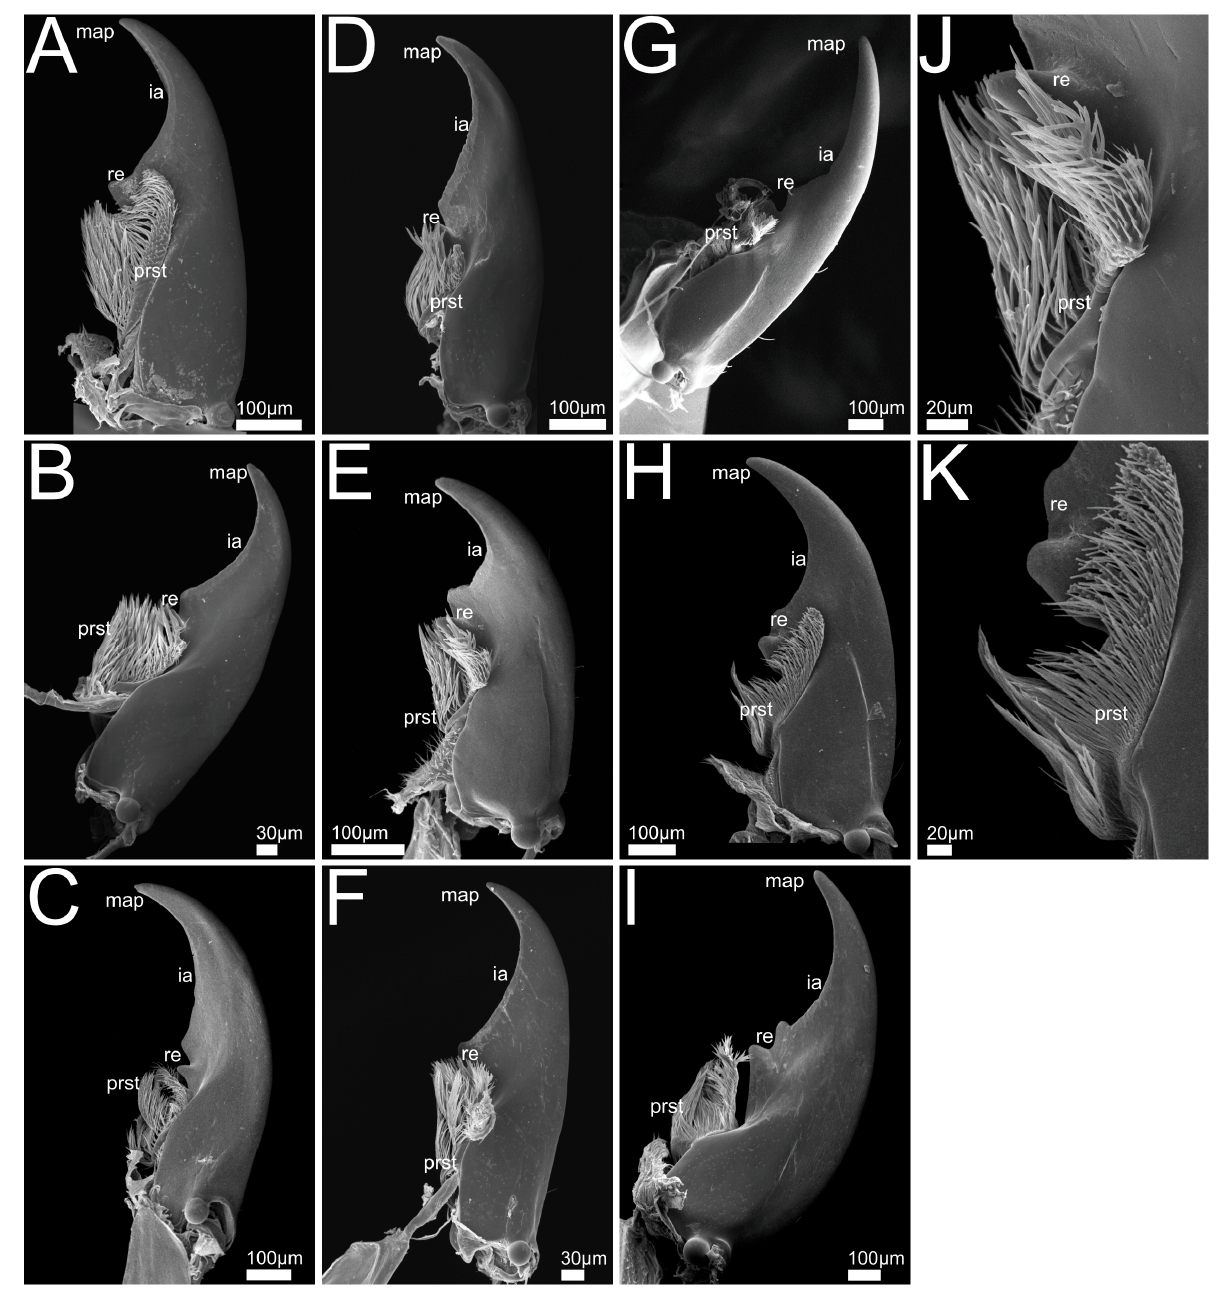
Figure 8. SEM views of Staphylinini mandible. Images A – I ventral aspect of mandible, J – K with detailed views of prostheca. ( A ) Bisnius sordidus ; ( B) Philonthus varians ; ( C ) P. marginatus ; ( D ) P. rufipes ; ( E ) P. discoideus , ( F ) P. alpinus ; ( G ) Quedius cinctus ; ( H ) Q. cruentus ; ( I ) Q. curtipennis ; ( J ) P. discoideus , ventral aspect of prostheca; ( K ) Q. cruentus , ventral aspect of prostheca. Abbreviations: ia: incisor area; map: mandibular apex; prst: prostheca; re: retinaculum.